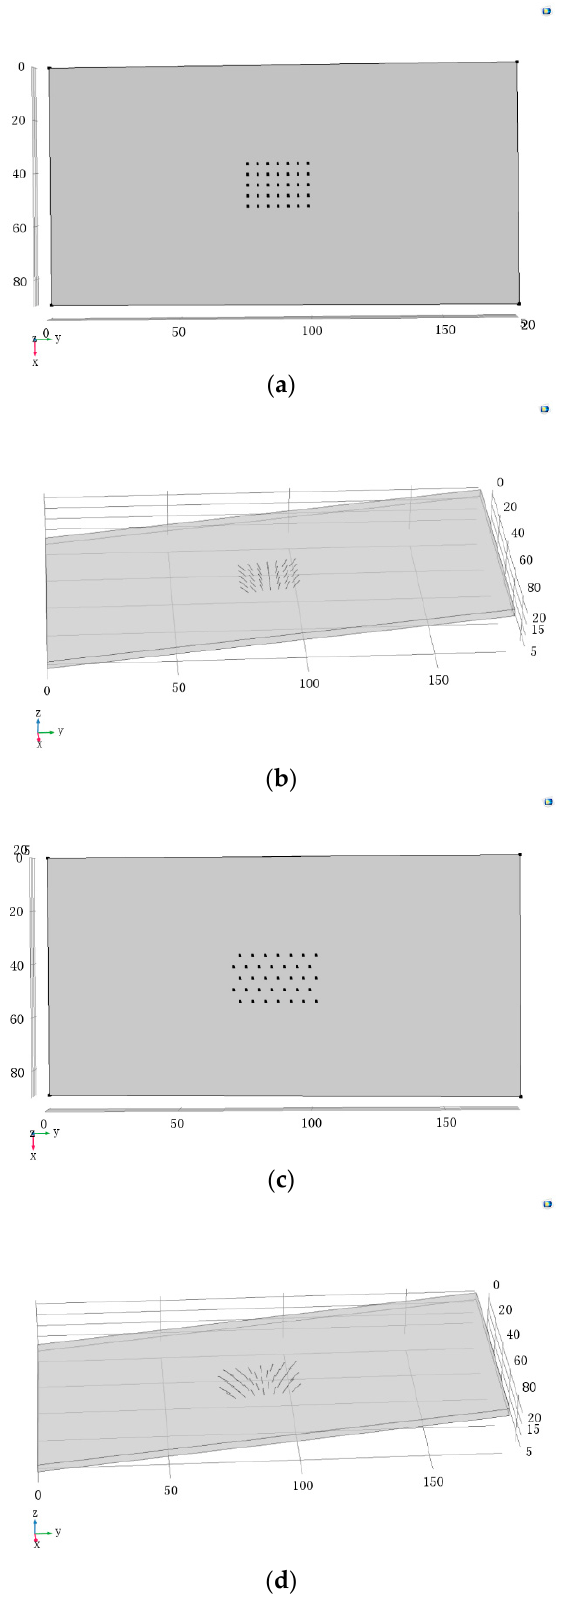
Figure 9. Geometrical models of rectangular configuration: ( a ) plan, ( b ) elevation and rhomboidal configuration, ( c ) plan, ( d ) elevation.